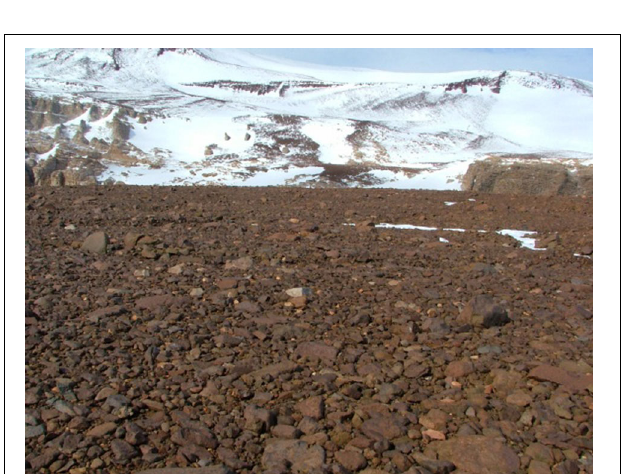
FIGURE 3 | The cryptic hypolithic habitat; a moss community associated with a quartz pebble.